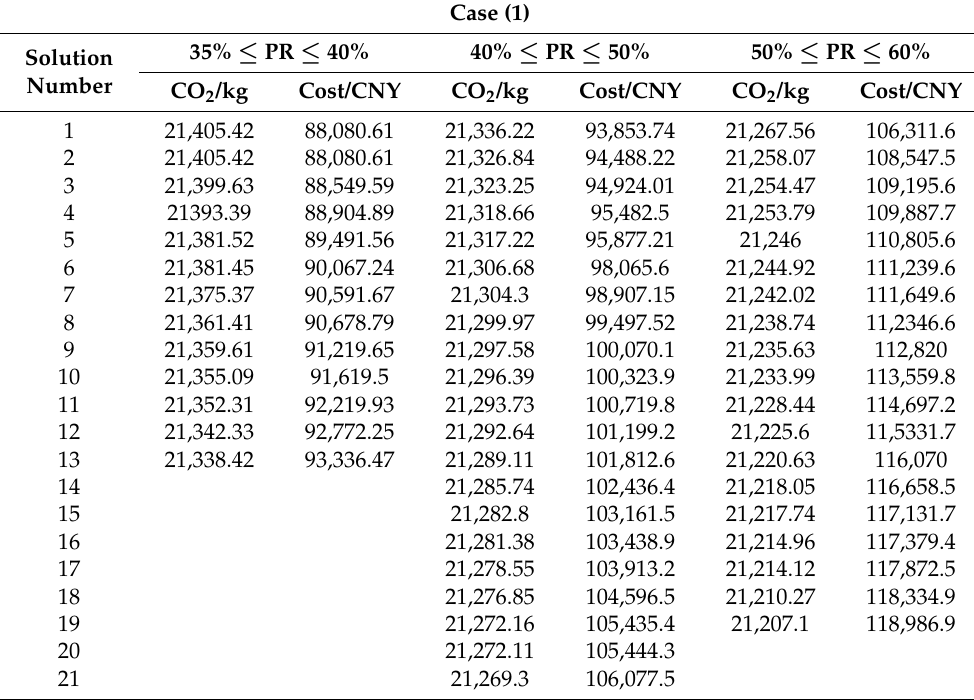
Table 4. Comparison of objective function values of Pareto optimal solution sets under different prefabrication rates (Case(1) Case(2) Case(3)).